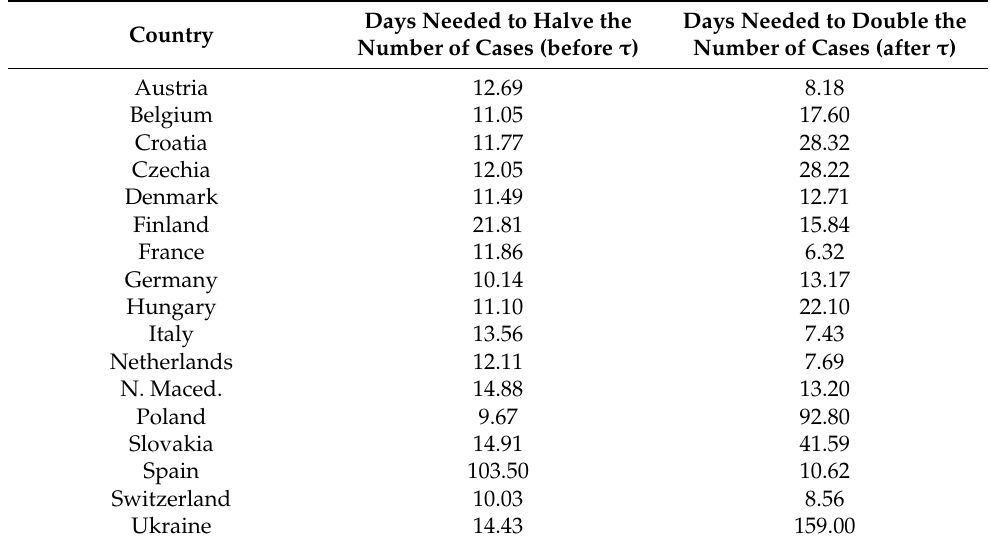
Table 2. Quantifying the inversion from a decrease to an increase in the SARS-COV-2 case rate for the countries of Table 1. Days Needed to Halve the Days Needed to Double Country Number of Cases (before τ )